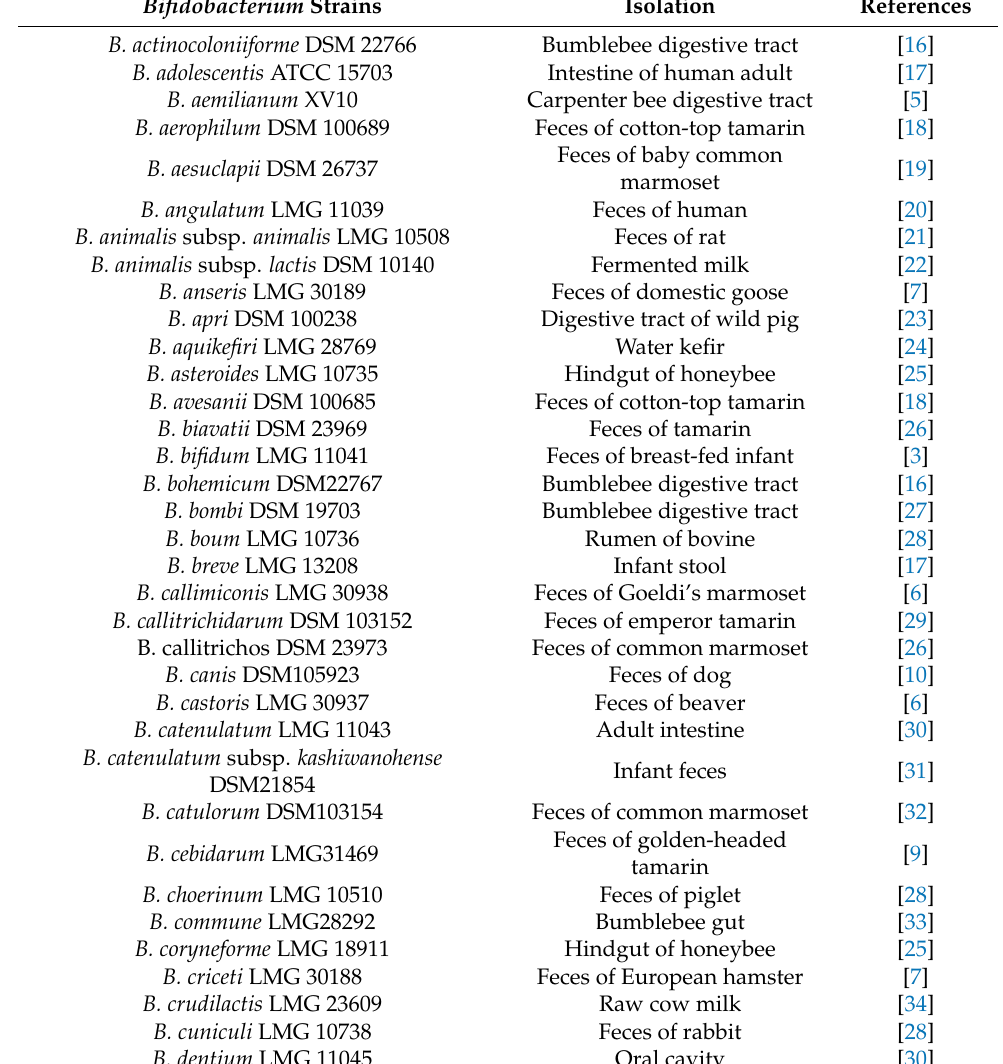
Table 1. Bifidobacterium (sub)species recognized as reference strains (type